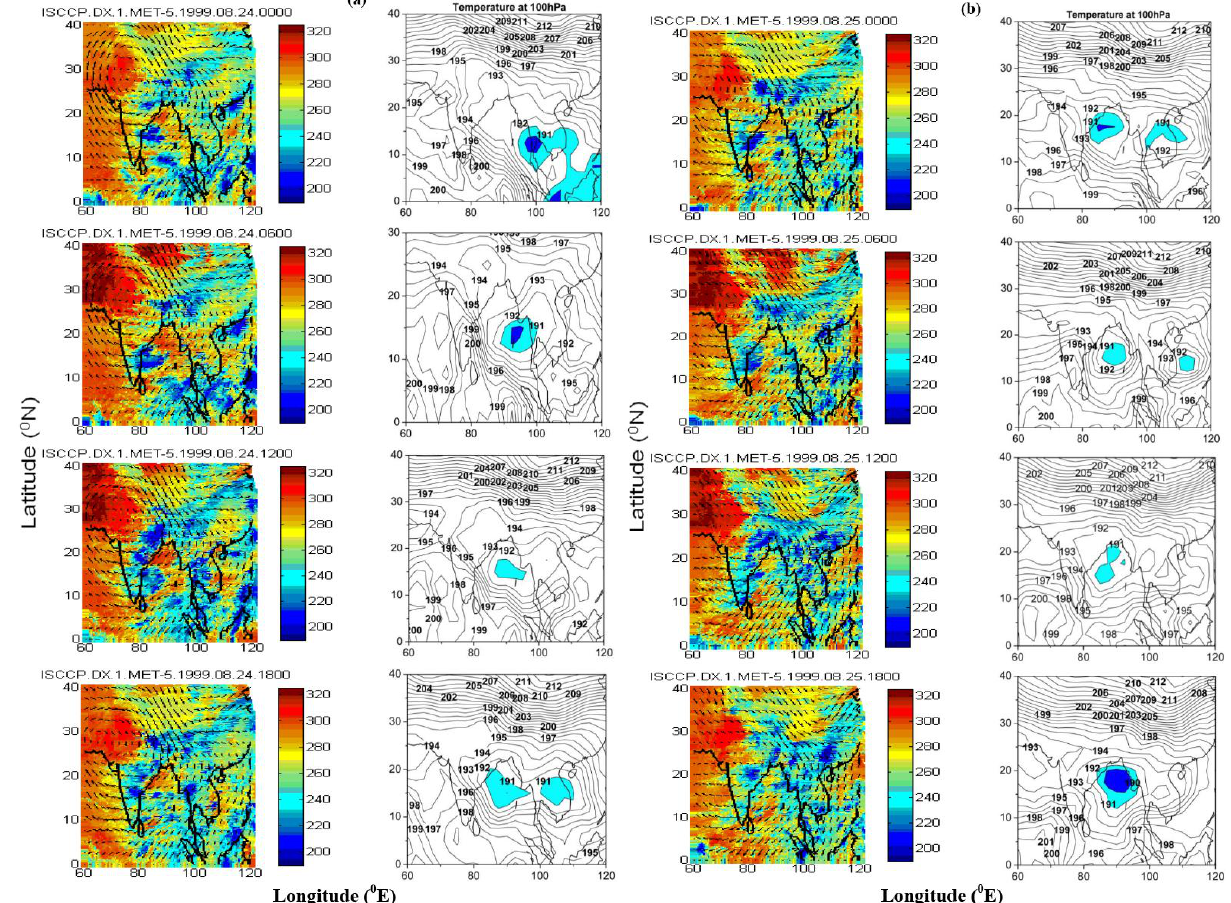
Fig. 8. Left hand side panels show satellite imageries drawn using 6 hourly ICSSP-DX data. Horizontal wind field at 100hPa level, corresponding to each of the satellite imagery, from ECMWF reanalysis is superposed. Right hand side panels show contour maps of temperature field at 100 hPa level. Contours of low T 100 temperature are shaded blue. Resolution of ECMWF reanalysis data presented in this particular figure is 2 . 5 ◦ × 2 . 5 ◦ . (a) 24 August 1999, 00:00GMT to 24 August 1999, 18:00GMT. (b) 25 August 1999, 00:00GMT to 25 August 1999,